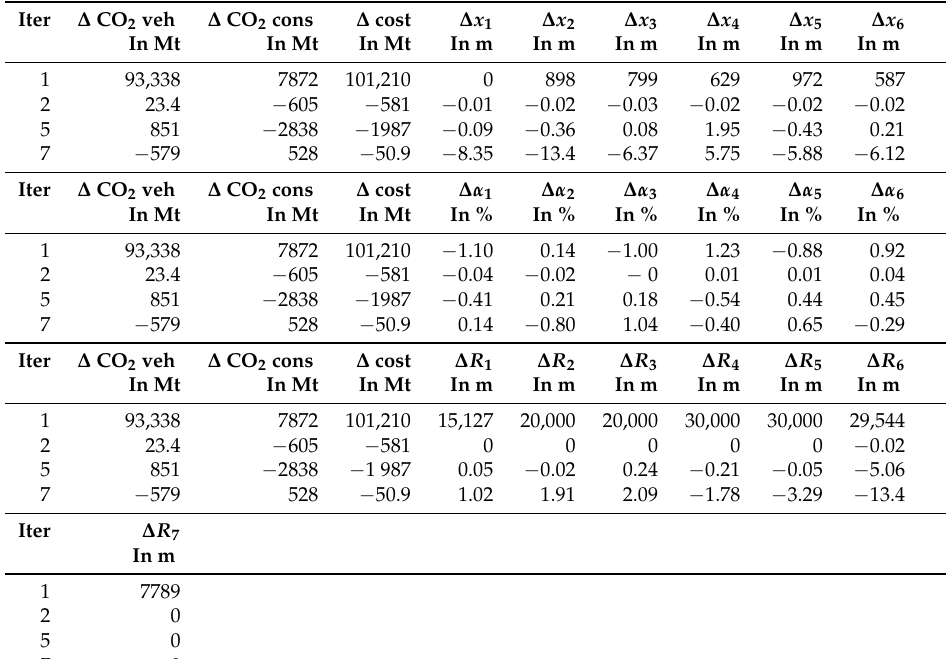
Table 5. Sensitivity of cost function depending on optimization